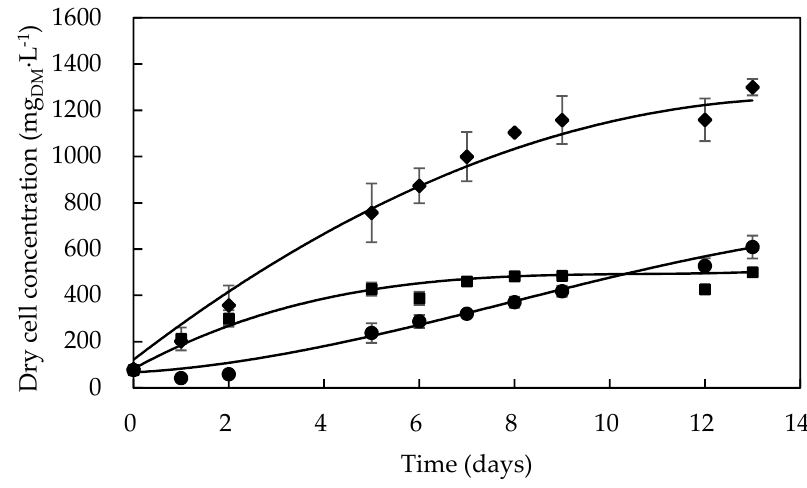
Figure 1. Growth profiles of Dunaliella tertiolecta (UTEX 999) cultivated in different culture media: F/2 medium ( (cid:4) ), Bold’s Basal medium ( • ), Alternative medium ( (cid:117) ).